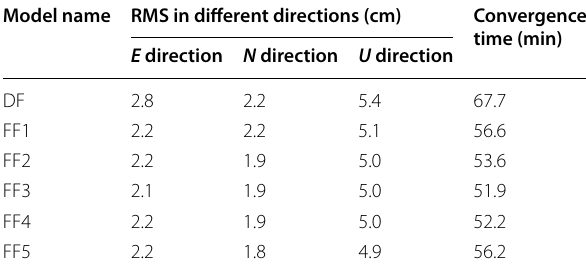
Table 4 Monthly medians of RMS and convergence time with 6 models for the selected 20